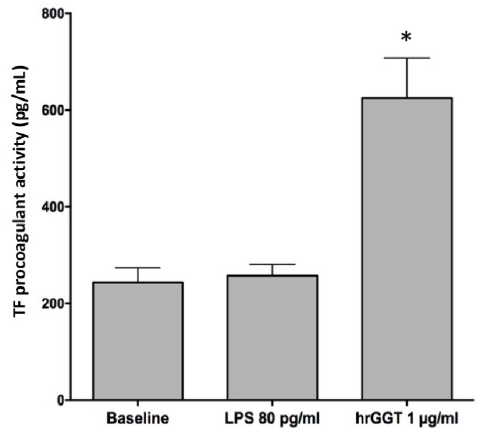
Figure 3. TF procoagulant activities measured in THP-1 cells stimulated by hrGGT (1 µg/mL) and LPS (80 pg/mL). Data are presented as means ± SEM ( n = 3). * p < 0.05 vs. LPS. A multiple comparison was performed by the Friedman test.